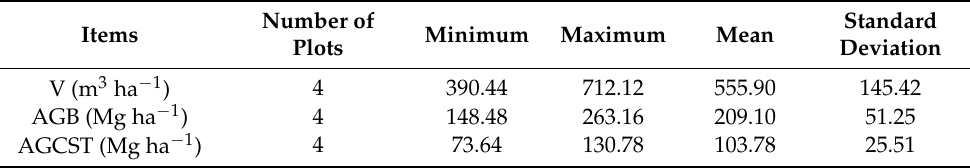
Table 6. The stand volume (V), aboveground biomass accumulation (AGB), and aboveground carbon storage (AGCST) predicted by the allometric model for the Konishii fir